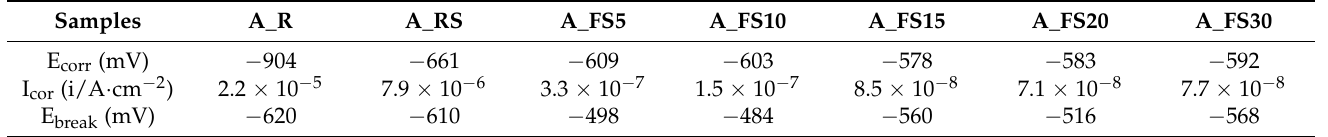
Figure 8. Polarization curves of AA6082 samples immersed in 3.5 wt.% NaCl aqueous solution. Table 3. Electrochemical parameters for the corrosion of different samples immersed in 3.5 wt.% NaCl aqueous solution.